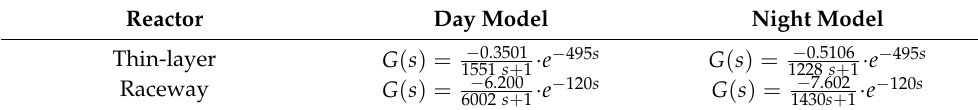
Table 1. Transfer functions of the raceway and thin-layer reactor, daytime and nighttime models, using wastewater from secondary treatment as culture medium.